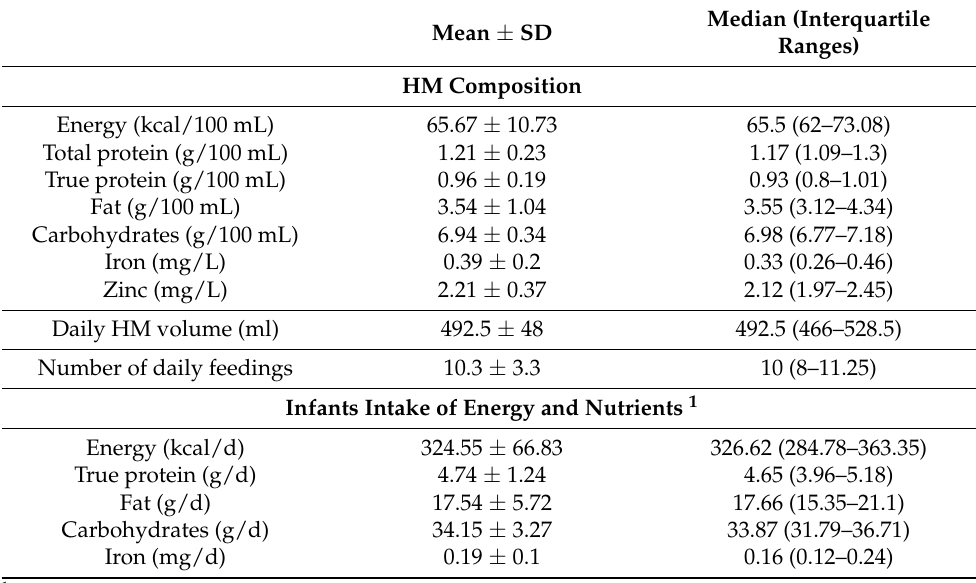
Table 4. The composition of HM and estimated nutrients